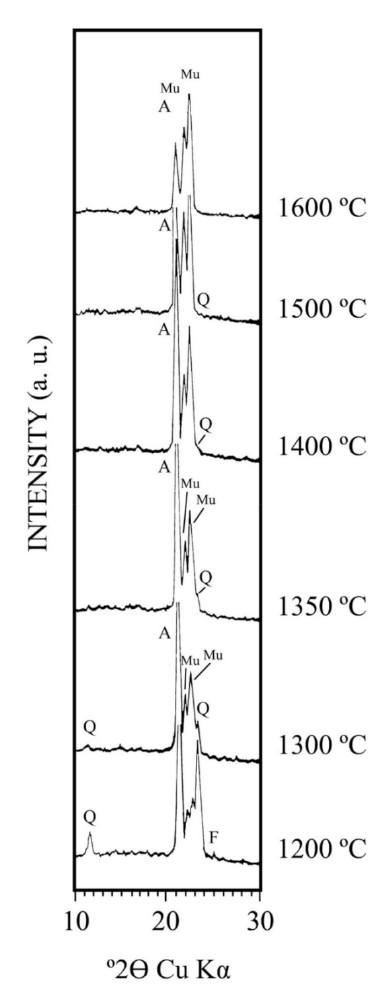
Figure 11. XRD diagrams of the mixture of kaolin sample (ground using a hammer mill) an α -alumina fired up to 1600 ◦ C for 2h. F = feldspar (microcline); Q = quartz; Mu = mullite; A = α